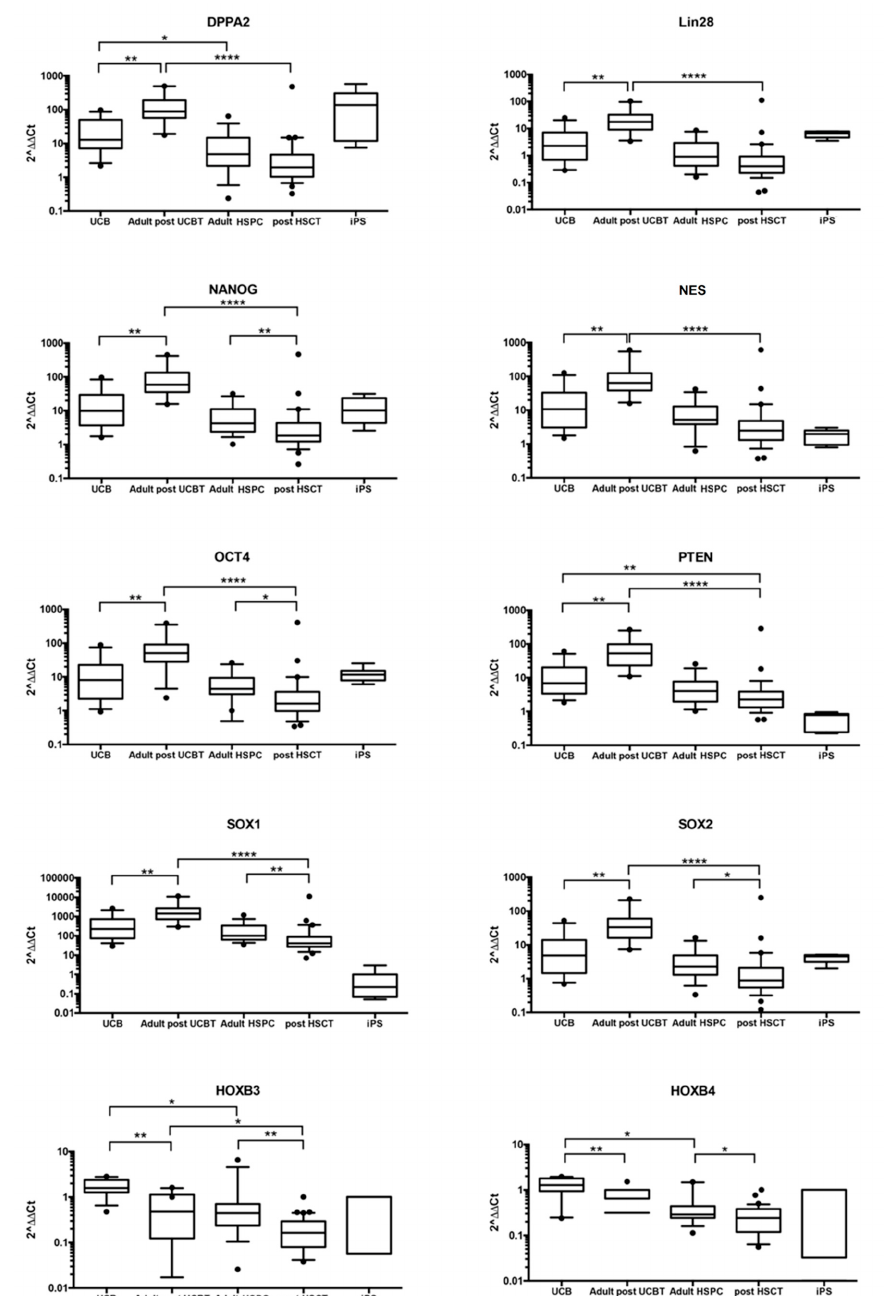
Figure 1. Gene expression analysis showed a di ff erent expression of DPPA2, LIN28, NANOG, NES, OCT4, PTEN, SOX1, SOX2, HOXB3, and HOXB4 in the 5 groups of samples evaluated. mRNA expression levels are expressed as 2 −∆∆ Ct in CD34+ cells separated from: umbilical cord blood (UCB) units, bone marrow (BM) cells from adult patients after UCB transplant (UCBT), from adult healthy donors (adult hematopoietic stem / progenitor cells (HSPC)), from BM cells from adult and pediatric patients after adult hematopoietic stem cell (HSC) transplant (post-HSCT) and iPS. Horizontal bars indicate the median value. Figure showed that DPPA2, LIN28, NANOG, NES, OCT4, PTEN, SOX1, and SOX2 were upregulated in UCBT compared to UCB group. In contrast, these genes were downmodulated in post HSCT compared to adult HSPC. HOXB3 and HOXB4 showed downregulation in both transplanted group (UCBT and HSCT) compared to UCB and adult HSPC, respectively. Except for OCT4, HOXB3, and HOXB4, less expressed in adult HSPC compared to UCB, no significant di ff erences were found between the two groups. (* p ≤ 0.05; ** p ≤ 0.01; **** p ≤